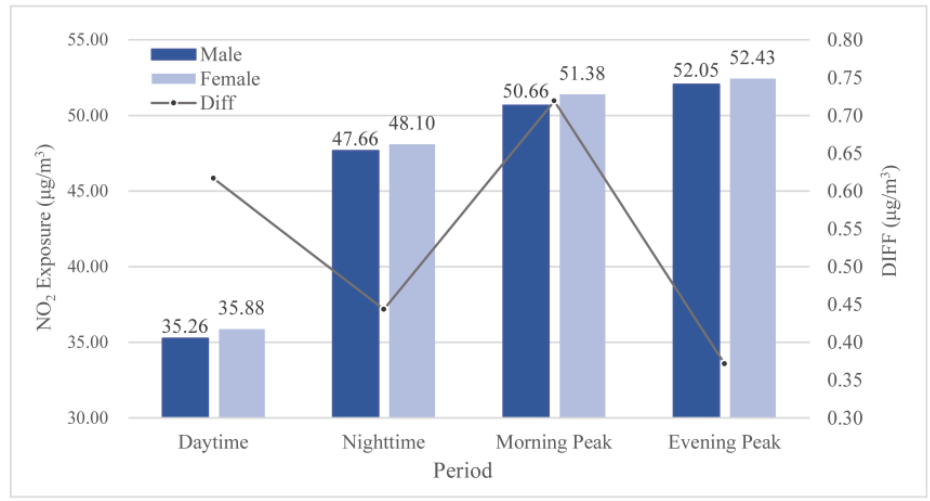
Figure 6. NO 2 exposure disparity between males and females.